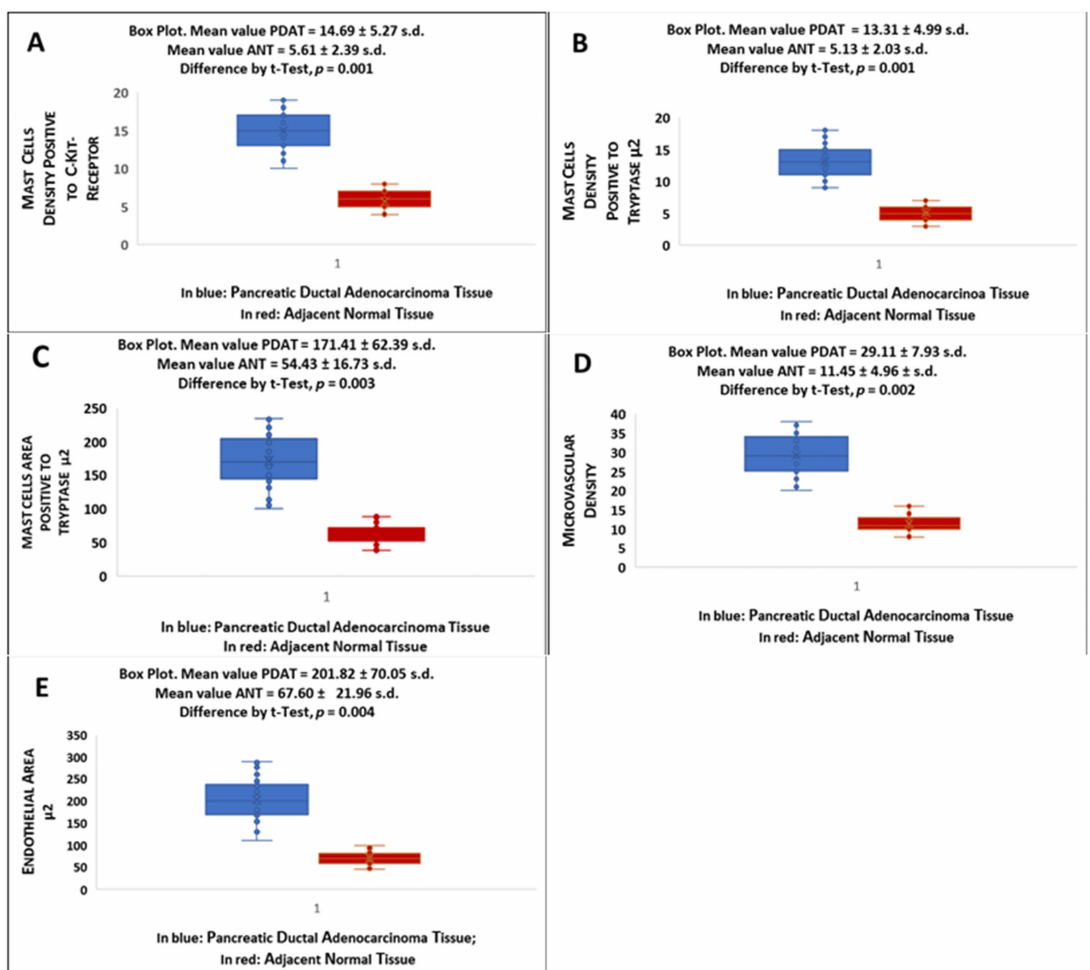
Figure 7. Boxes plot indicate mean ± standard deviation of ( A ) MCDP-c-KitR, ( B ) MCDPT, ( C ) MCAPT, ( D ) MVD and ( E ) EA in PDAT and ANT, respectively, and corresponding differences by Student’s t -test in terms of p